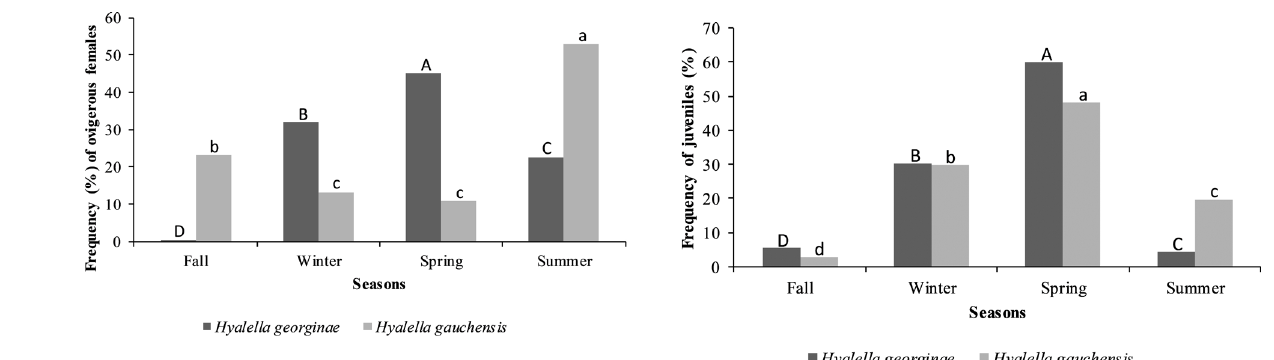
Figure 9. Relative frequency (%) of juveniles of Hyalella georginae and Hyalella gauchensis by season of the year, Palmeira das Missões, state of Rio Grande do Sul, Brazil. Capital letters correspond to the comparisons of the frequency of juveniles of Hyalella georginae among the seasons of the year and the small letters correspond to the comparisons of the frequency of juveniles of Hyalella gauchensis among the seasons of the year. Collumns with at least one letter in common did not differ statistically (p < 0.05).